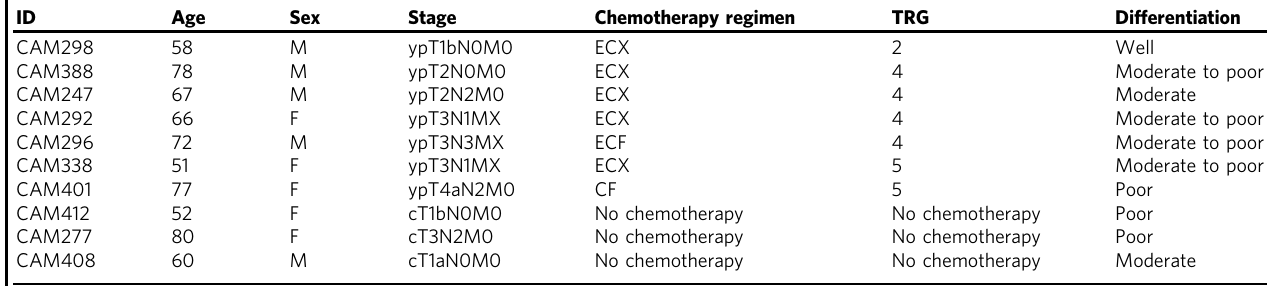
Table 1 Summary table of clinical characteristics of patient